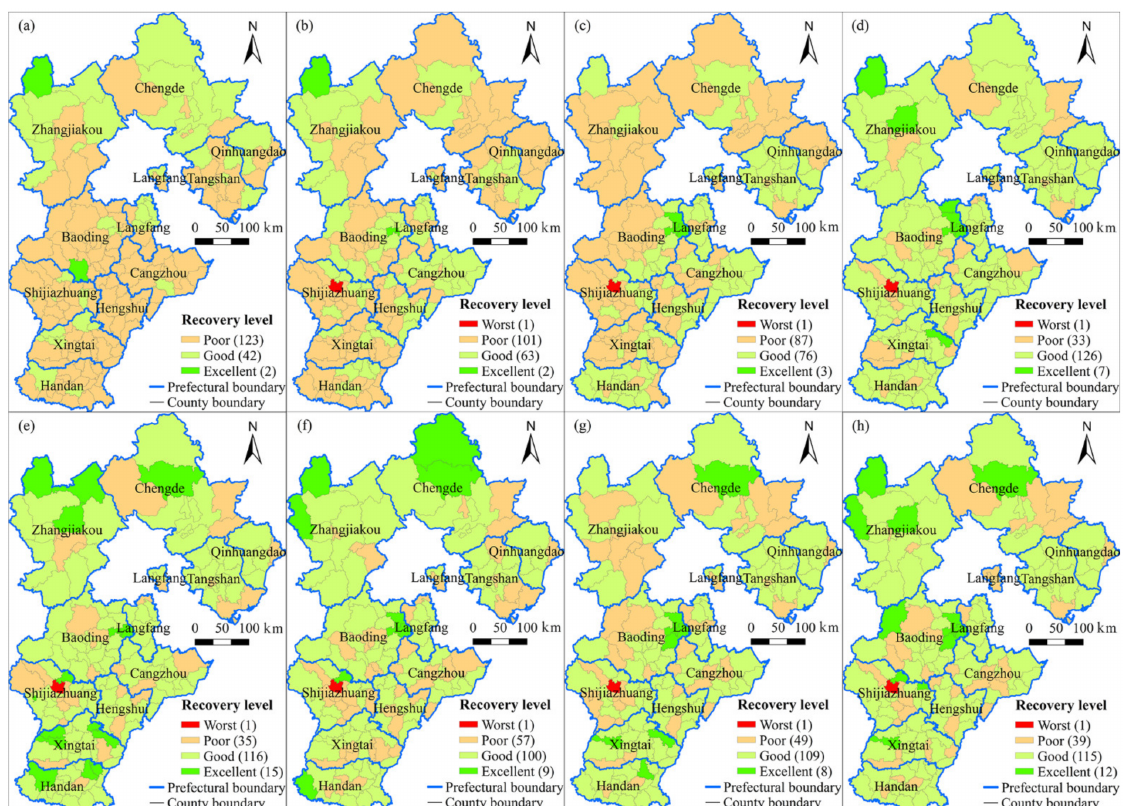
Figure 7. Economic recovery status of county-level cities in Hebei Province in Q1 ( a ), Q2 ( b ), Q3 ( c ), and Q4 ( d ) of 2020; and economic recovery status of county-level cities in Hebei Province in Q1 ( e ), Q2 ( f ), Q3 ( g ), and Q4 ( h ) of